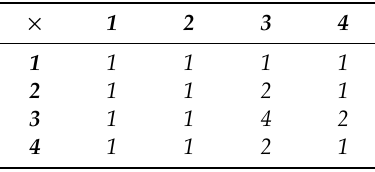
Table 9. The operation × on